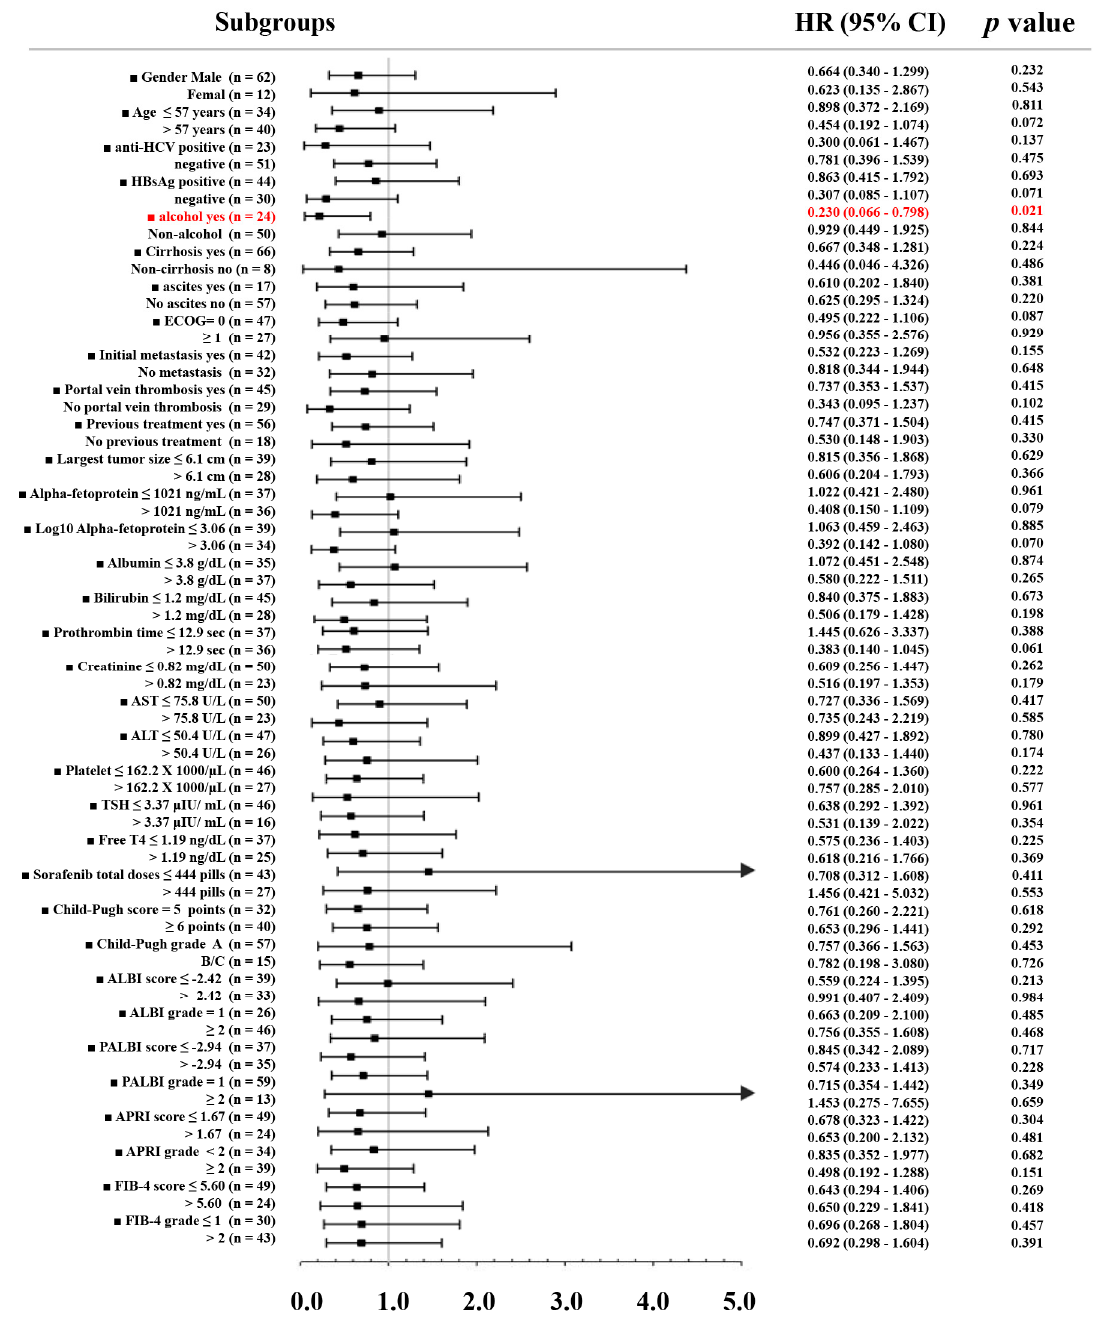
Figure 3. Forest plot analysis for overall survival in relation to the rs1010816 “TT” genotype in different clinical subgroups of sorafenib-treated patients. The mean values of clinical parameters were used as cutoffs. Red values indicate statistical significance p < 0.05. HR—hazardous ratio; CI—confidence interval.